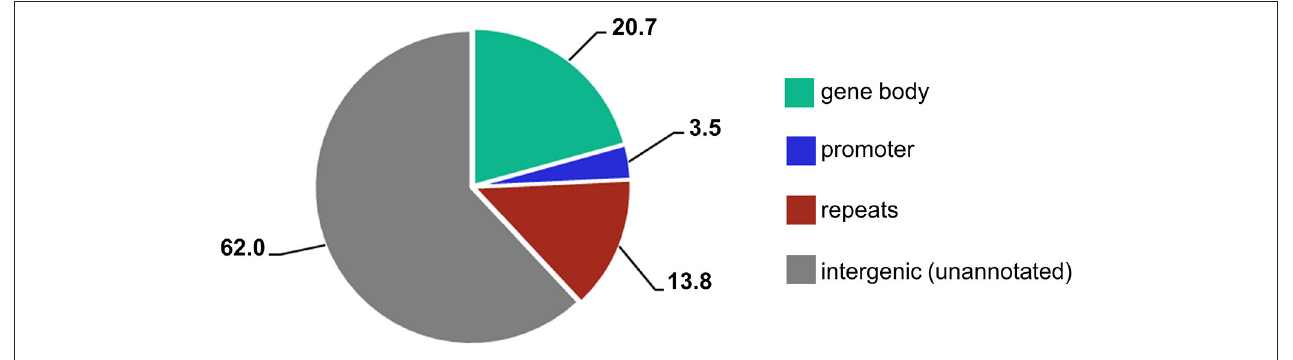
FIGURE 3 | Percentages of different genic features identified within MSAP-Seq tags.